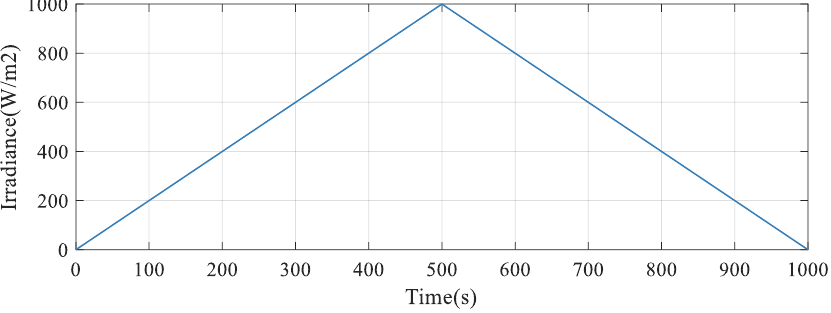
Figure 26. Fluctuation of light intensity in Example 3. The DC bus output voltage value of Example 3 is shown in Figure 27.